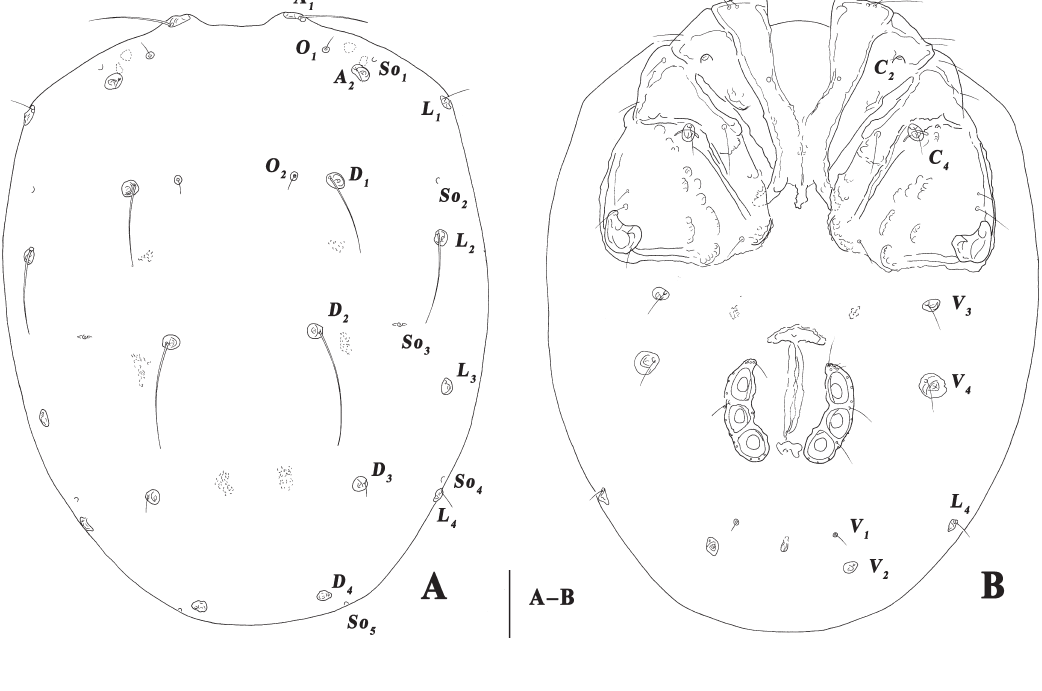
Fig. 12. Atractides ( Atractides ) xianmiensis Zhang, Li & Guo sp. nov., paratype, ♀ (GUGC, Slide No. QH-HY-2020072914). A . Idiosoma, dorsal view. B . Idiosoma, ventral view. Scale bar = 100